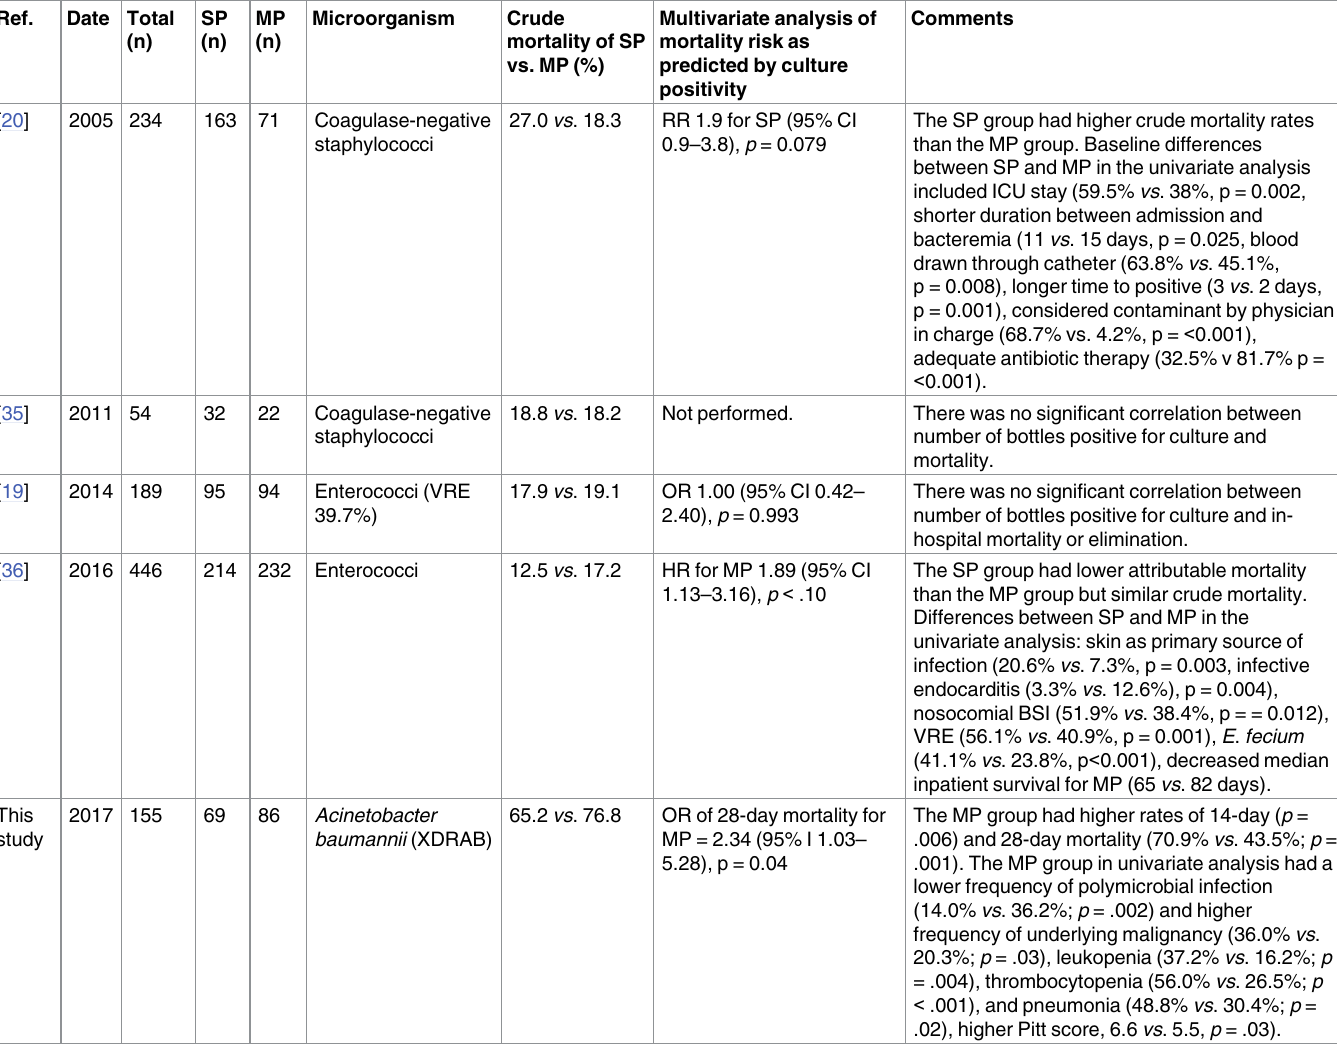
Table 3. Review of studies post-1990scomparing the associated mortality of single-positive (SP) versus multiple-positive (MP) blood cultures based on the identity of the microorganism.